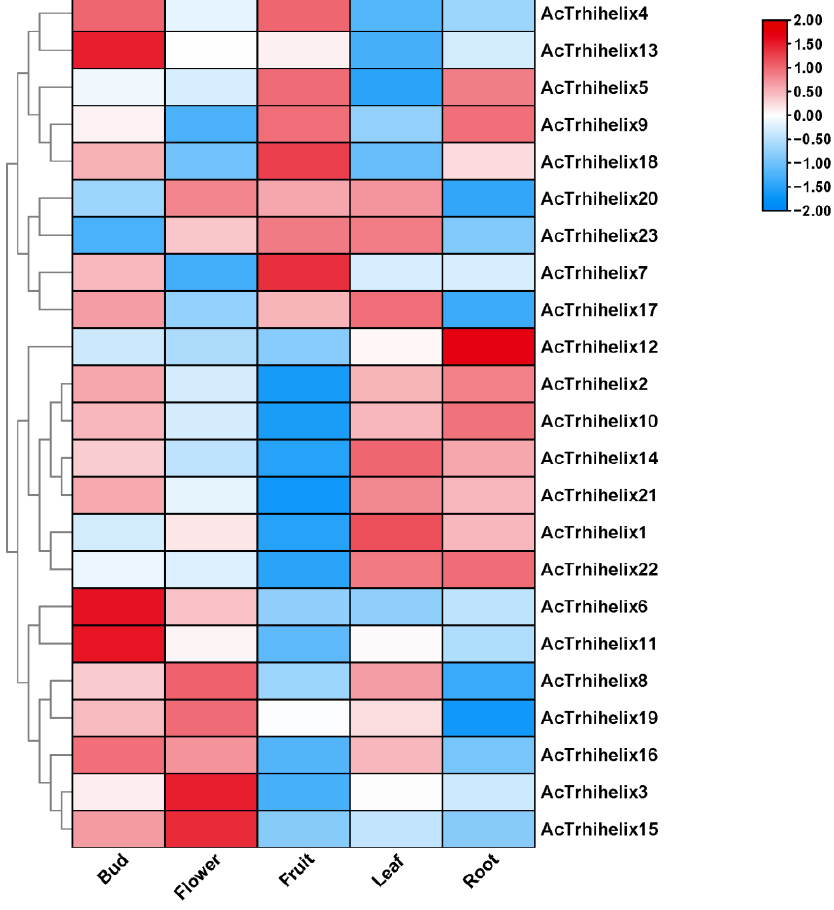
Figure 6. Expression profile of AcTrihelix genes in different tissues of pineapple. The labels of the X -axis represent the different organs of the pineapple. The Y -axis refers to the deduced FPKM value normalized with Log2.